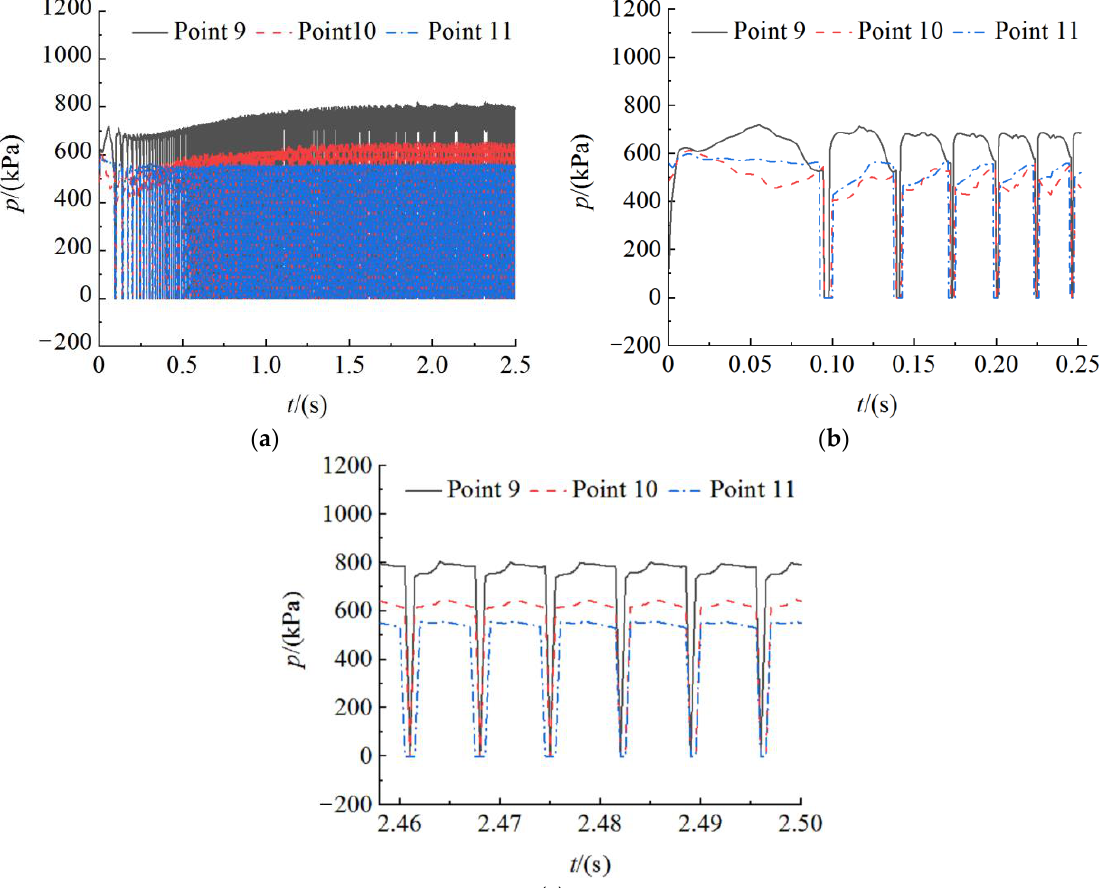
Figure 15. Time domain of pressure fluctuation in impeller. ( a ) t = 0~2.5 s; ( b ) t = 0~0.255 s; ( c ) t = 2.458~2.5 s.